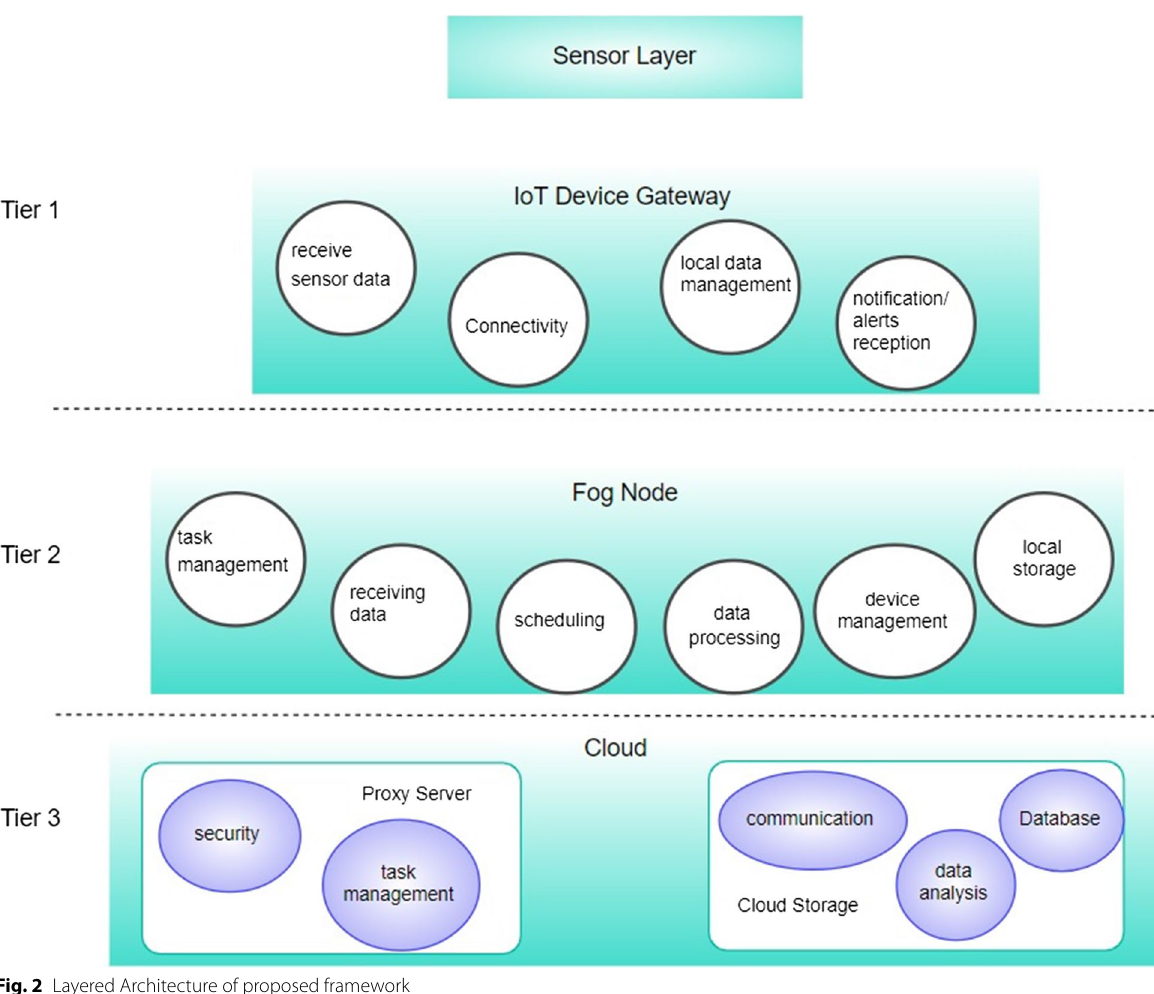
Fig. 2 Layered Architecture of proposed framework